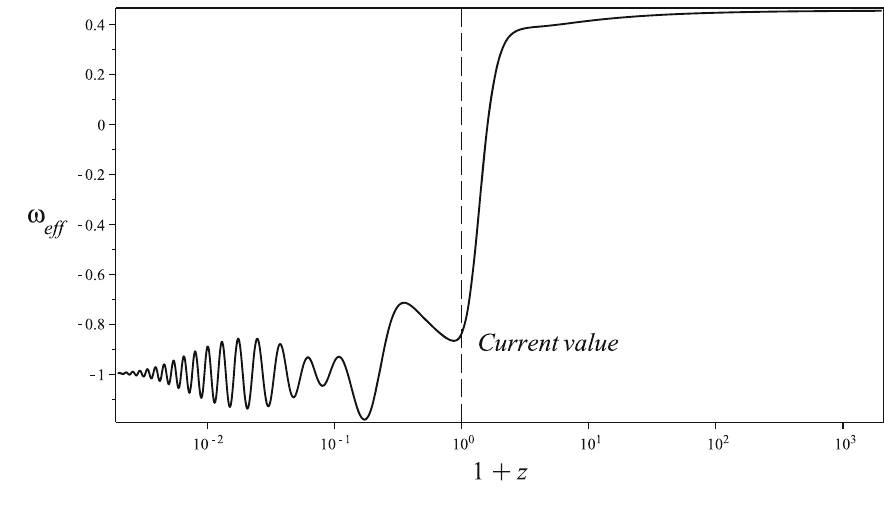
Fig. 5 The evolution of EoS parameter against redshift: for best fitted